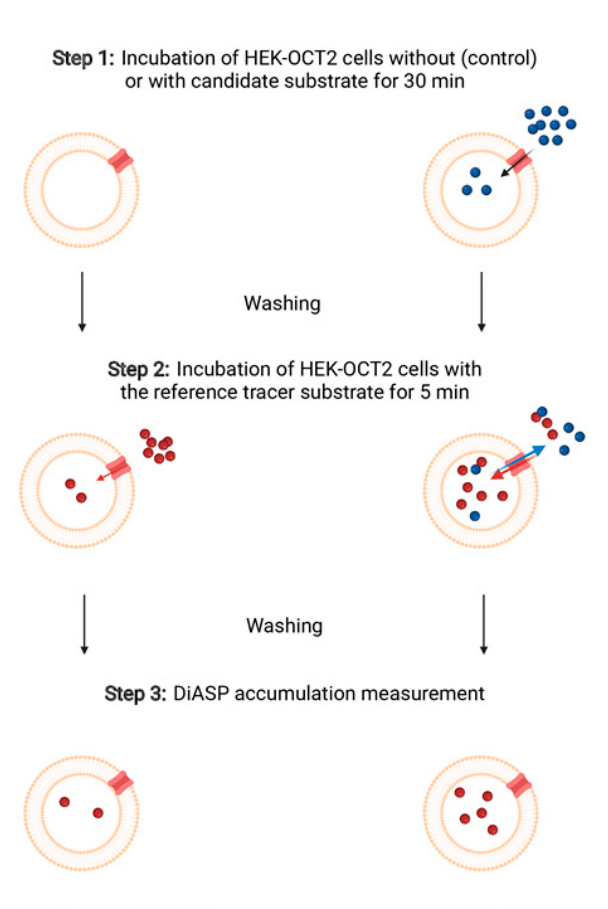
Figure 4. Schematic representation of the various steps of the trans -stimulation assay performed for investigating OCT2 substrates (created with biorender.com). Step 1 corresponds to the initial incubation of cells without (Control) or with candidate substrate for 30 min at 37 ◦ C. Step 2 consists of the incubation of cells with the reference tracer substrate (DiASP) for 5 min at 37 ◦ C. Step 3 is the measurement of cellular accumulation of DiASP through spectrofluorimetry.